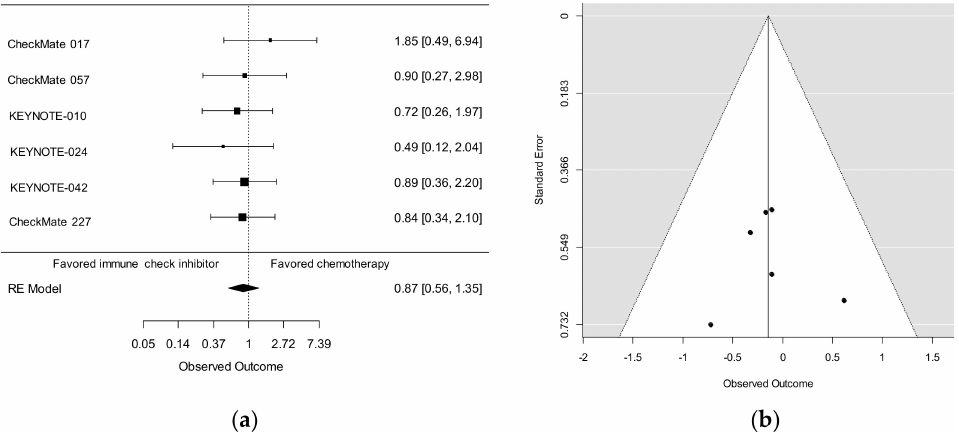
Figure 1. The meta-analysis was conducted using a random e ff ects model, which weighed studies using the restricted maximum likelihood method. Studies were combined by pooling the hazard ratios (log scale) and corresponding standard errors. No significant di ff erence was observed between immune checkpoint inhibitor therapy and chemotherapy ( a ). Funnel plots of the six studies revealed little publication bias ( b ). The package ‘metafor’ in the R Statistical Platform, v3.5.1 (R Foundation, Vienna, Austria), was used for the